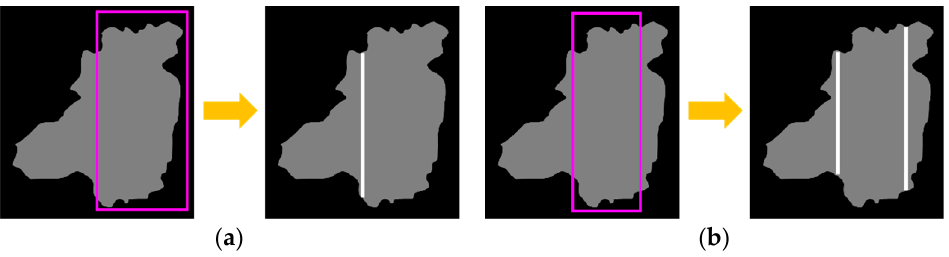
Figure 7. Segmentation with a single useful BB: ( a ) single boundary line; ( b ) two boundary lines.